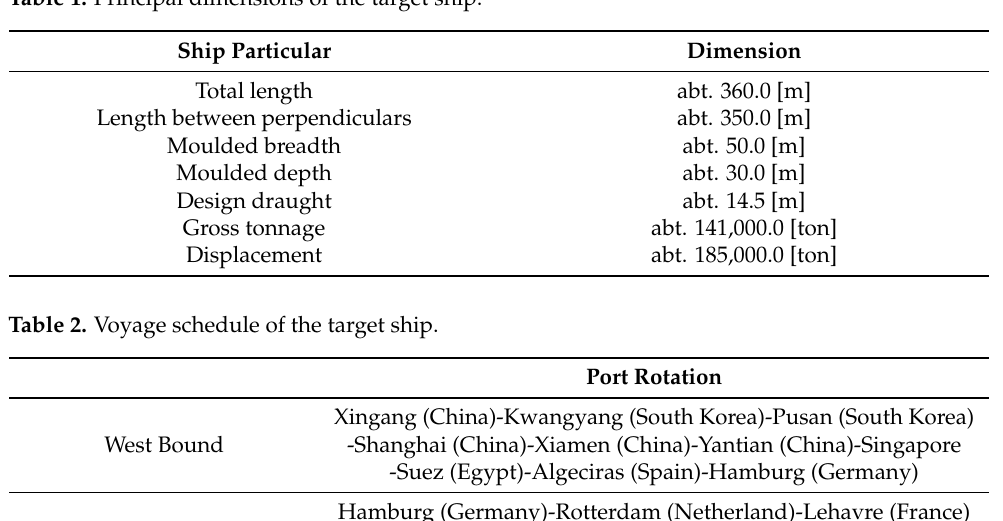
Table 1. Principal dimensions of the target ship.